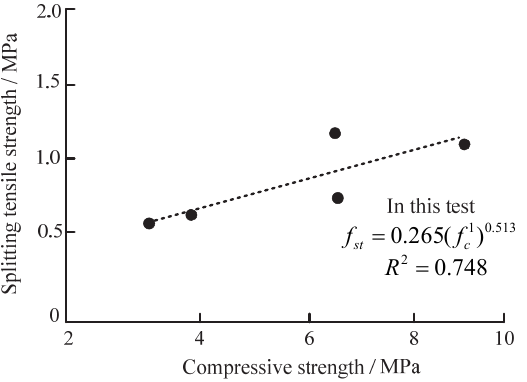
Figure 7: Compressive strength and splitting tensile